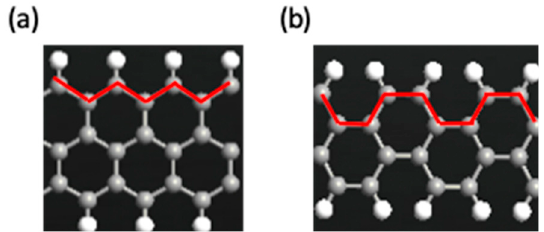
Figure 1. Schematic diagram of ( a ) zigzag graphene nanoribbon ( b ) armchair graphene